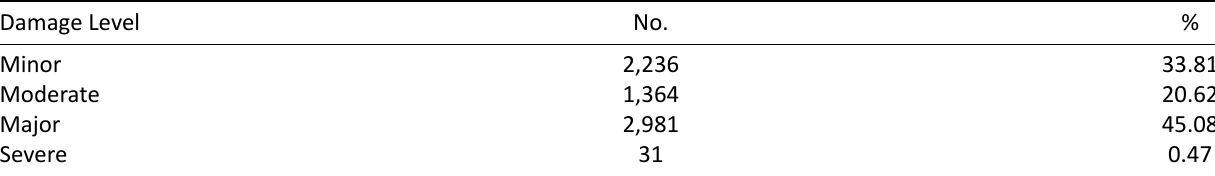
Table 1. Damaged buildings in Beirut from August 4th